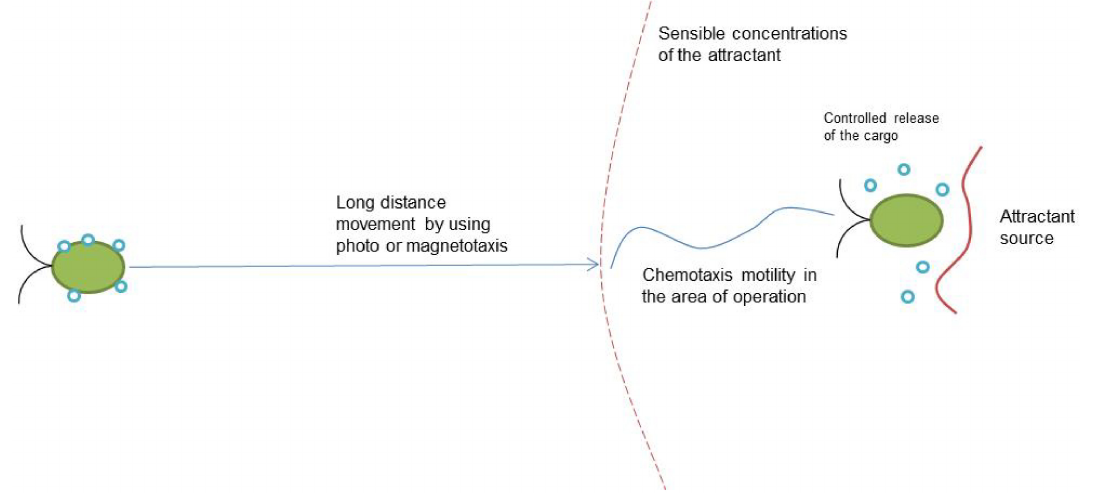
Figure 2. Variant of the application of the two motility types for the